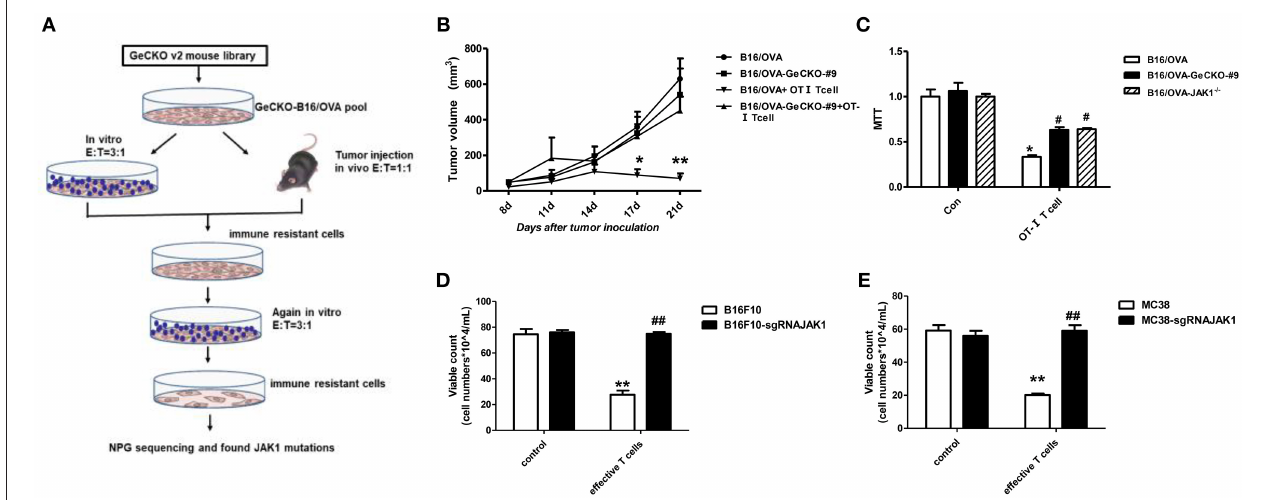
FIGURE 1 | Identification of JAK1 as a candidate factor responsible for T-cell resistance by genome-wide CRISPR/Cas9 screening. (A) Screening procedure for genes associated with B16/OVA resistance to T-cell killing. (B) Wild-type (WT) B6 mice ( n = 5/group) were subcutaneously injected with 5 × 10 5 B16/OVA or B16/OVA-GeCKO#9 cells, then 1 × 10 6 OT-I T-cells were administered on days 8 and 12. Tumor size was measured twice a week. Data represent mean ± SEM. (C) B16/OVA, B16/OVA-GeCKO#9, and B16/OVA-JAK1 − / − were co-cultured with OT-I T-cells and tumor cell viability was evaluated 72h later. (D,E) Number of live JAK1-deficient B16F10 and MC38 cells co-cultured with specific T-cells for 72h. Data are presented as mean ± SEM. * P < 0.05 vs. B16/OVA/B16F10/MC38 control group; # P < 0.05 vs. B16/OVA/B16F10/MC38 + T-cell group. ** P < 0.01 vs. B16/OVA/B16F10/MC38 control group; ## P < 0.01 vs. B16/OVA/B16F10/MC38 + T-cell group.